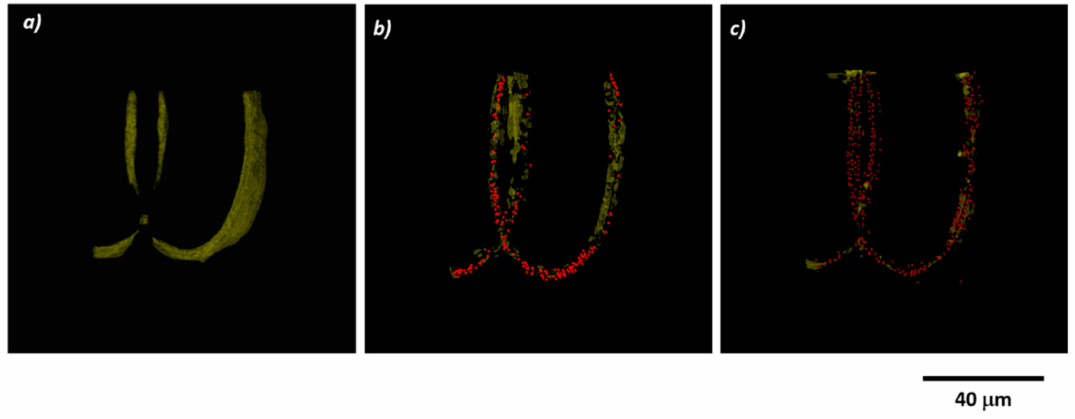
Figure 3. Images obtained by enhanced dark field microscopy using the Cytoviva three-dimensional (3D) module for sca ff olds with MNPs concentration of: ( a ) 0 mg / mL; ( b ) 2mg / mL; ( c ) 4 mg / mL.